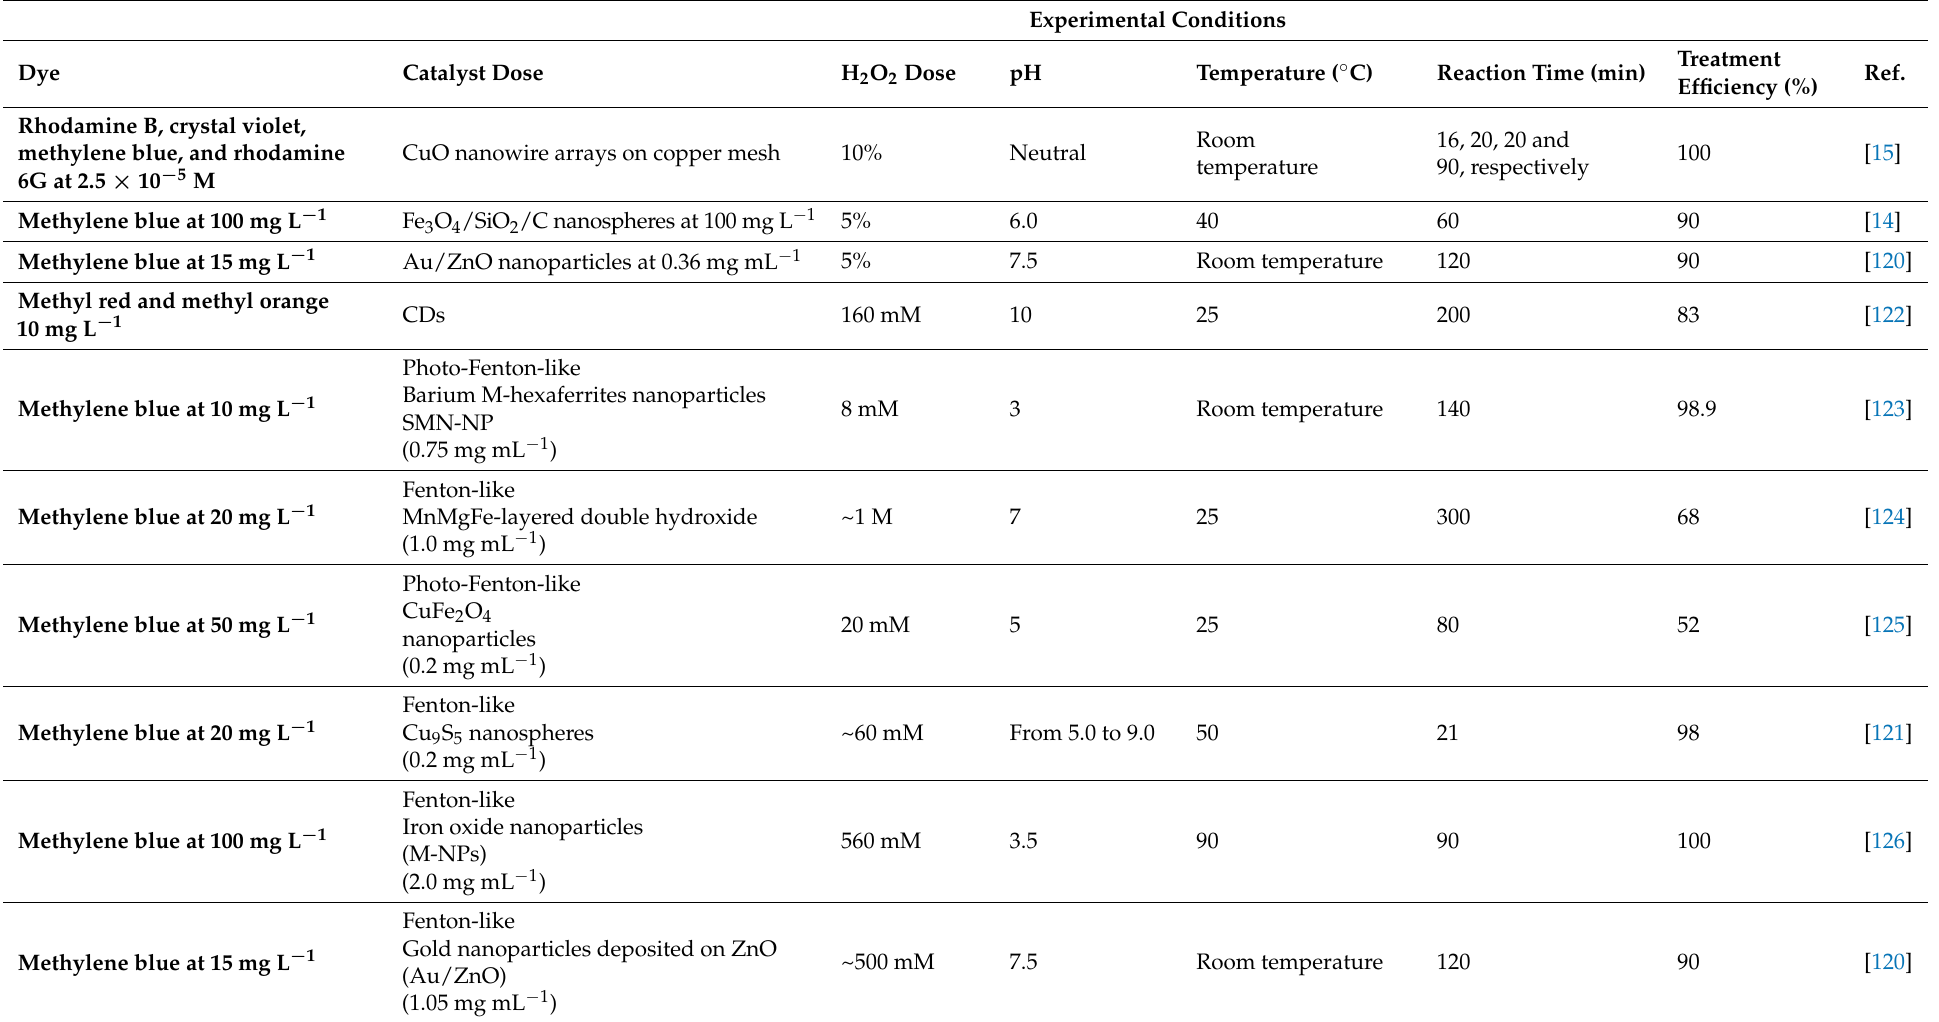
Table 2. Use of different nanocatalysts and parameters in the decolourisation/remediation of dyes via H 2 O 2